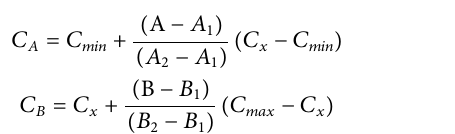
Frontiers in Earth Science |